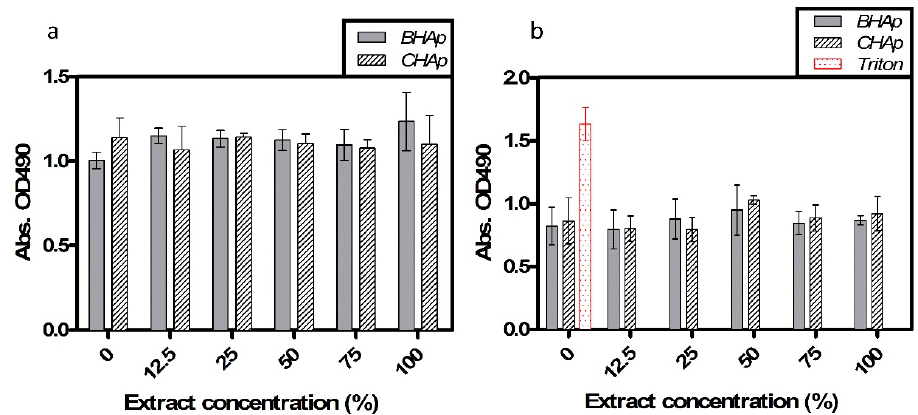
Figure 8. Cell viability after 72 h of exposure to different extract concentrations: ( a ) MTS assay; and ( b ) cytotoxicity by LDH assay. Data were normalized and compared (mean, SD, n = 6) using a two-way ANOVA, no significant differences considering p < 0.05.